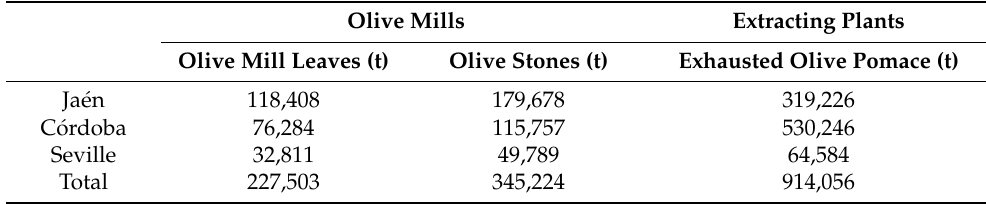
Table 3. Supply capacity of biomass from olive mills and olive pomace-extracting industries located in the study area. Olive Mills Extracting Plants Olive Mill Leaves (t) Olive Stones (t) Exhausted Olive Pomace (t) Ja é n 118,408 179,678 319,226 C ó rdoba 76,284 115,757 530,246 Seville 32,811 49,789 64,584 Total 227,503 345,224